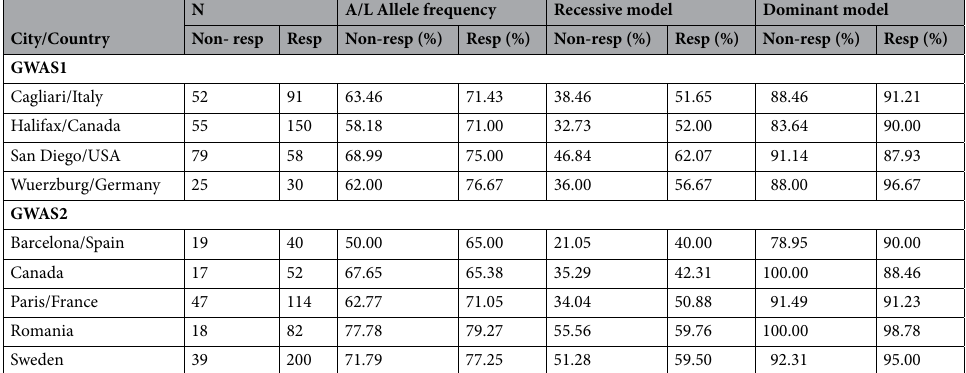
Table 4. Country by country distribution of the patients carrying the HLA-DRB1 alleles A or L at position 74. Non-resp = Li non responders (ALDA subscale A less than or equal to 3); Resp = Li responders (ALDA subscale A greater than or equal to 7); N = number of patients in the group; recessive model = percentage of patients carrying only the A or L allele; dominant model = percentage of patients carrying at least one allele A or